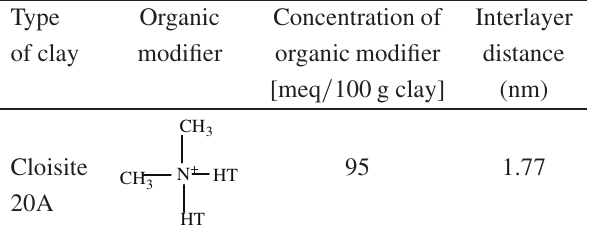
Table 1. Organic modifiers and interlayer distance of the